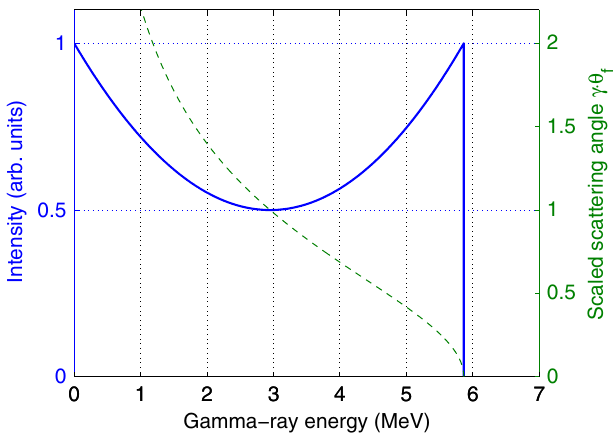
FIG. 6. The computed energy distribution of Compton gamma- ray photons produced by a head-on collision of a 800 nm laser beam with a 500 MeVelectron beam. The scaled scattering angle (cid:1)(cid:2) with the electron Lorentz factor versus the gamma-ray f photon energy is also shown in the plot. The solid line represents the energy distribution of the gamma-ray photons, and the dashed line represents the relation between the scaled scattering angle and photon energy.